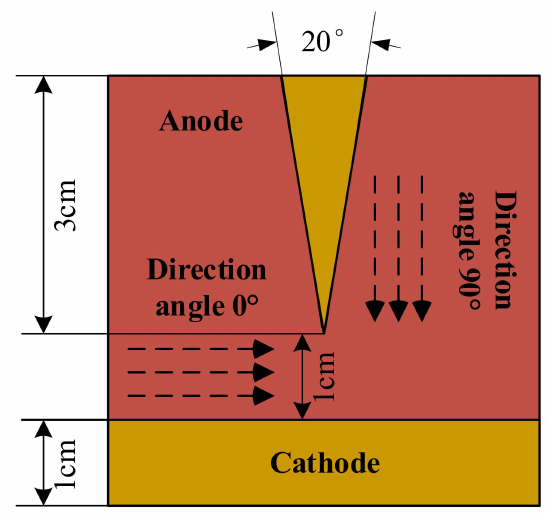
Figure 1. Experimental sample parameters and airflow direction settings.